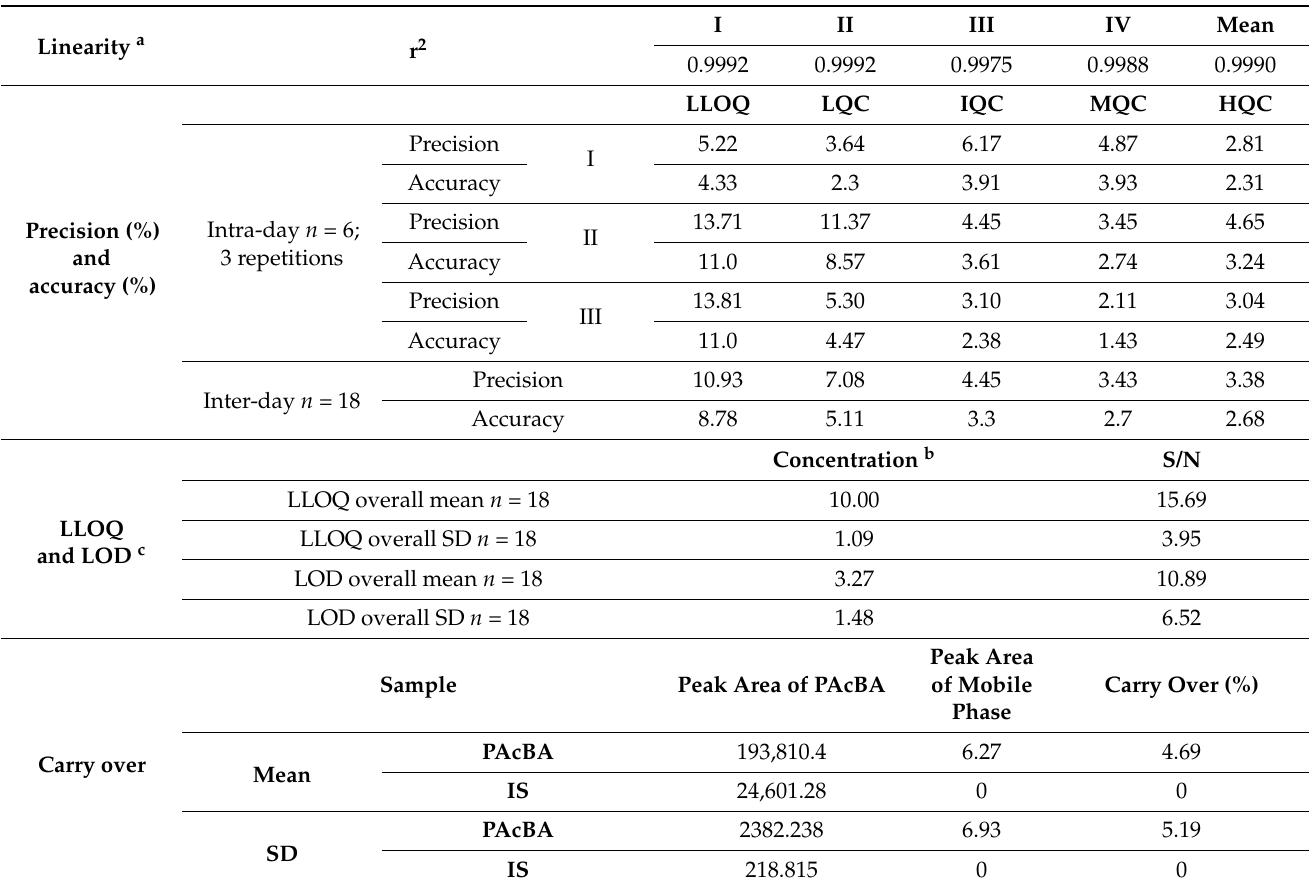
Table 3. Selected validation tests results of 4-acetamidobenzoic acid (PAcBA) and deuterium-labeled (d3) 4-acetamidobenzoic acid (internal standard;